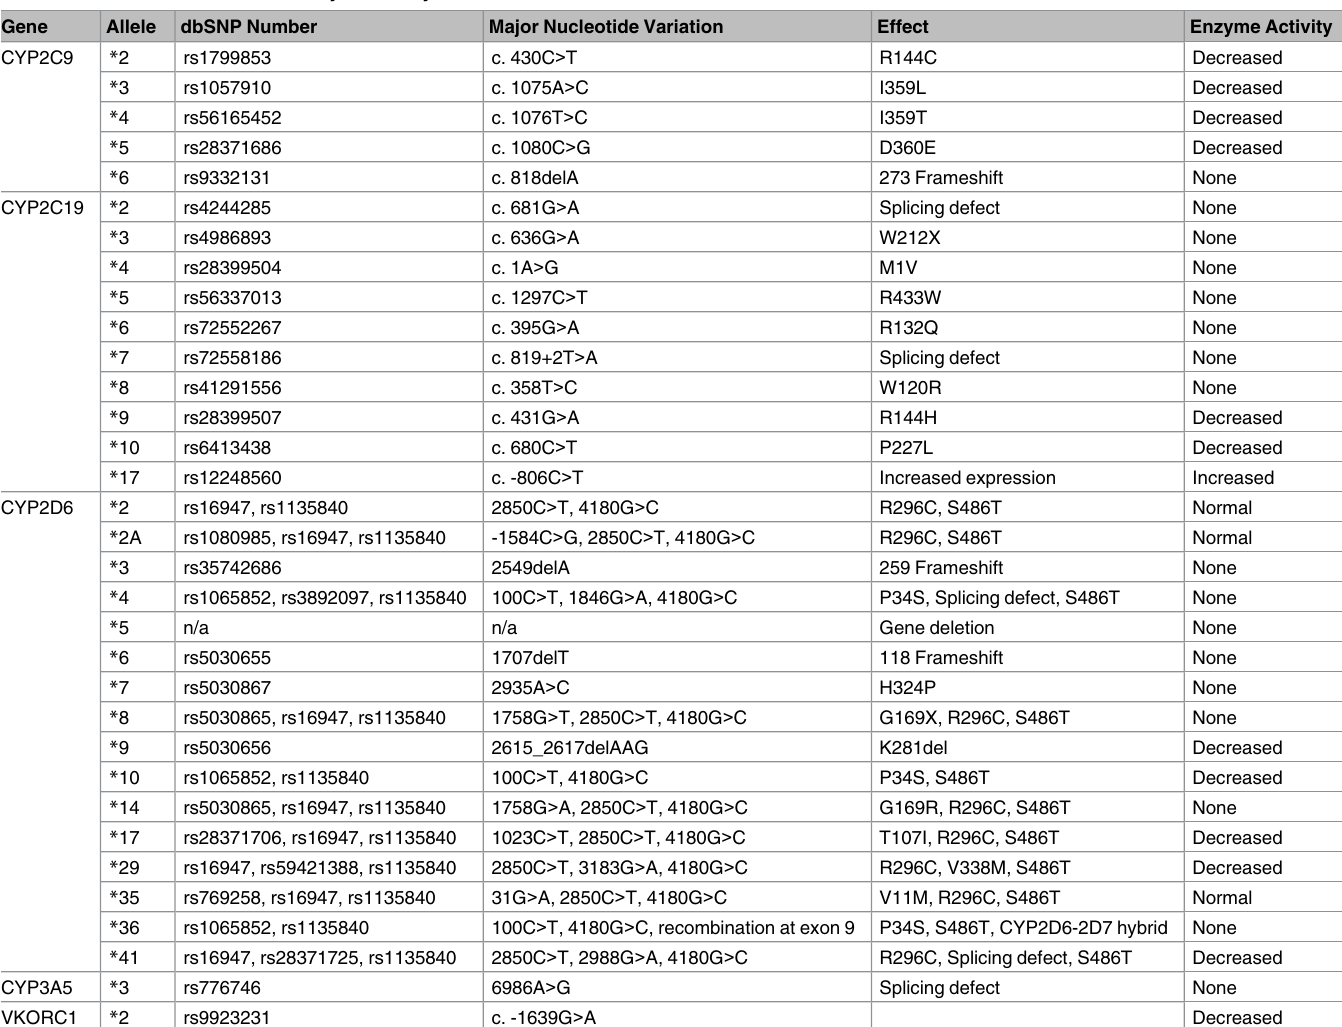
Table 1. Loci and alleles detected by the